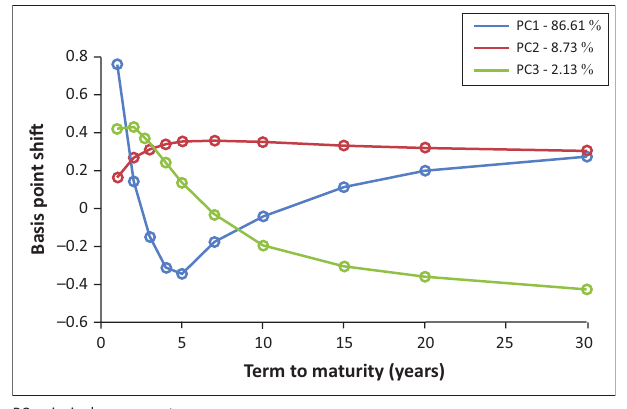
FIGURE 6: The three most important factors driving movements in United States swap rates: 2000–2014.